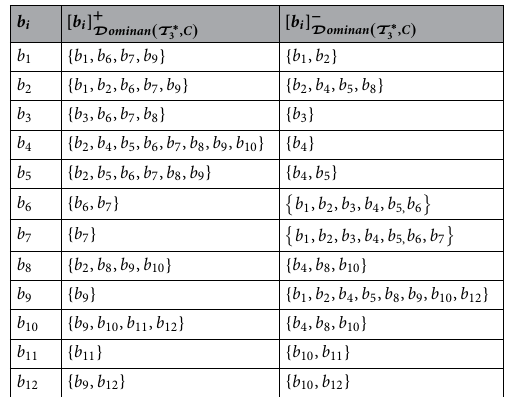
Table 4. Dominating classes [ b i ] + D ominan ( T ∗